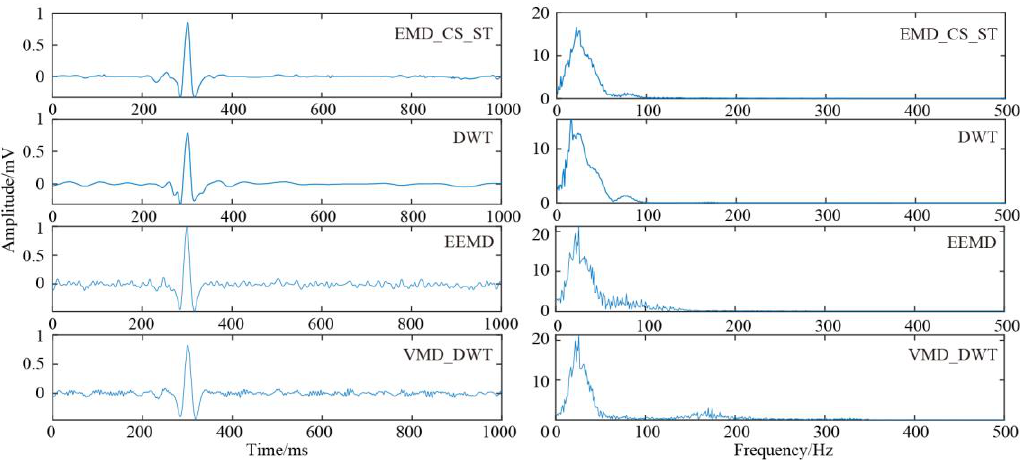
Table 1. Four methods for comparative analysis of the denoise effect.